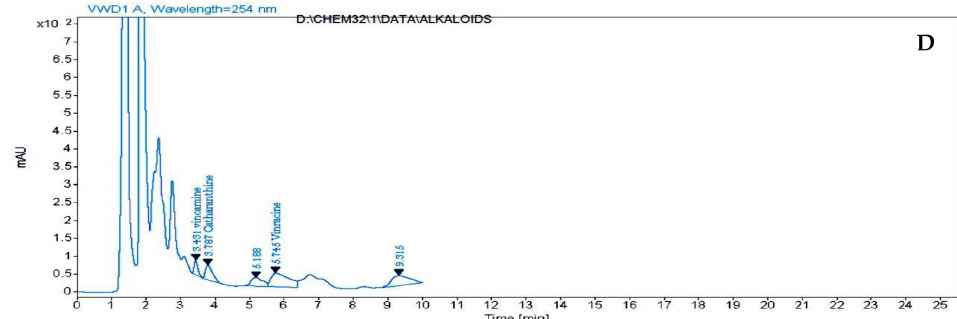
Figure 3. HPLC chromatograms of alkaloids ( A ) control ( B ) T1; Catharanthus roseus treated with 400 ppm carrageenan ( C ) T2; C. roseus treated with 600 ppm carrageenan ( D ) T3; C. roseus treated with 800 ppm